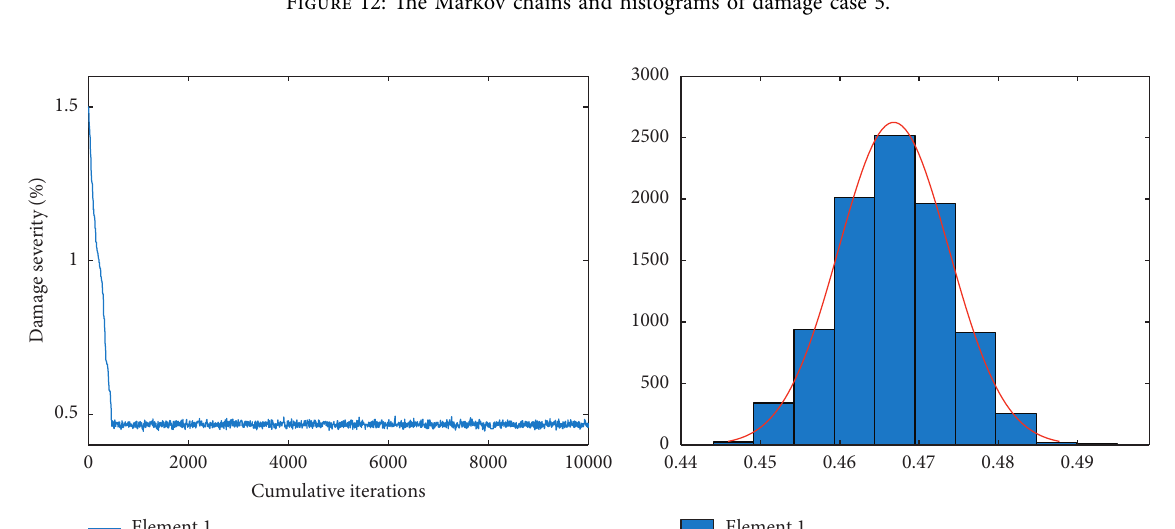
Figure 13: The Markov chains and histograms of damage case